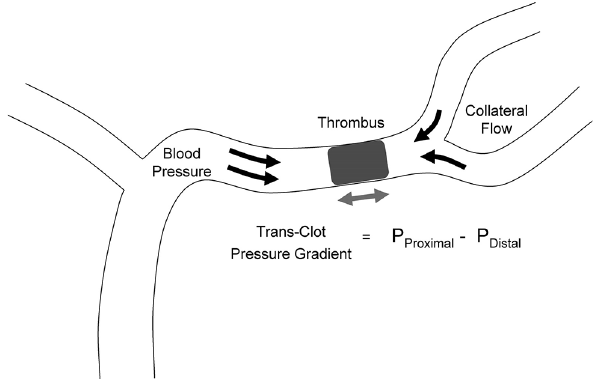
Fig. 4 Potential hydromechanical forces influencing the degree of throm- bus impaction. P Proximal pressure on the proximal aspect of the clot; P Distal pressure on the distal aspect of the clot. P Proximal pressure is increased by higher arterial pressure. P Distal pressure is increased by higher retro- grade arterial pressure (e.g., collateral flow). (From Nogueira RG,